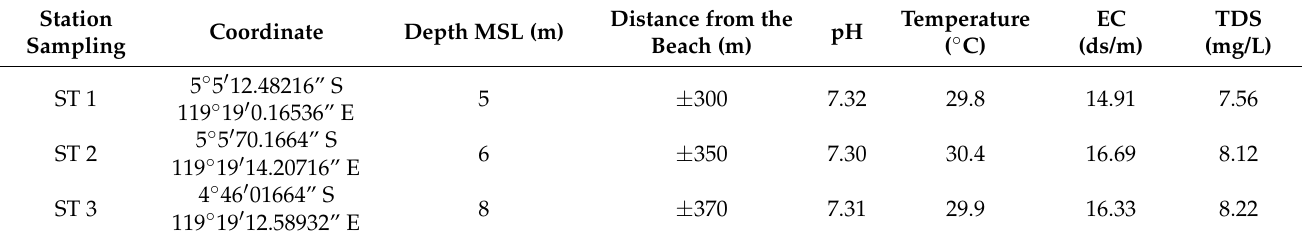
Table 1. Physical characteristics of the seawater sampling stations in the waters around